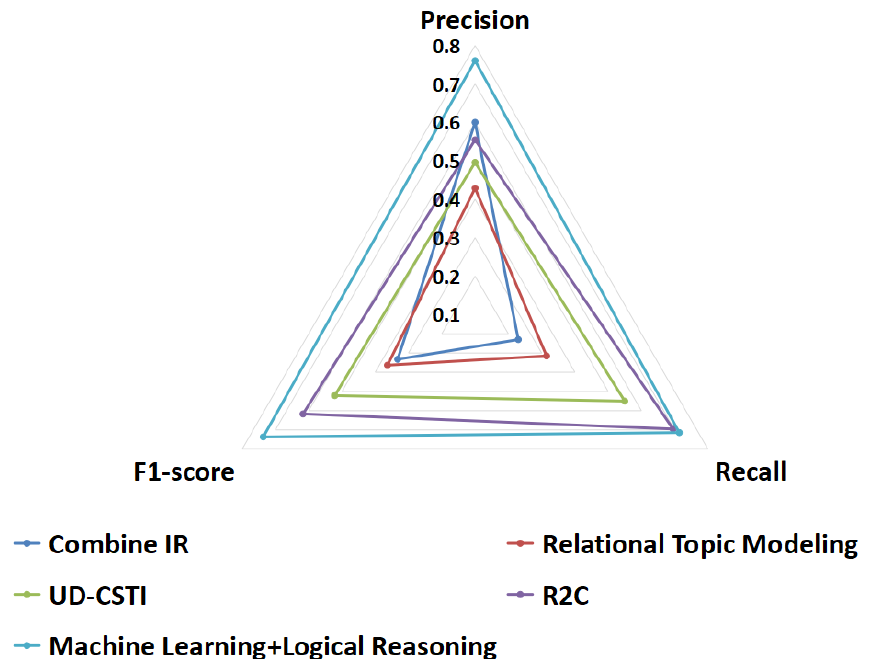
Figure 16. The result of comparing our proposed approach with methods proposed by related researchers on the eTour